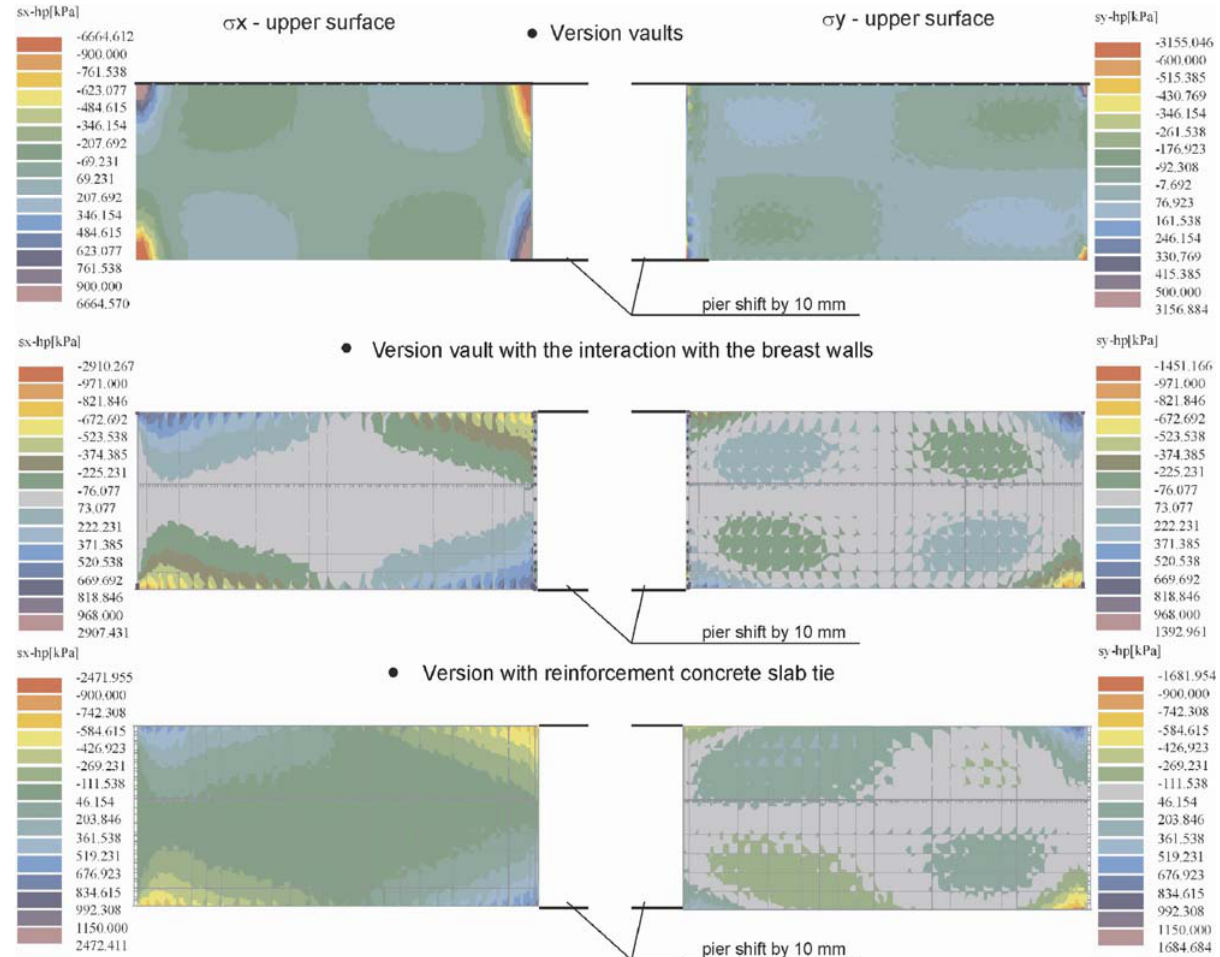
Fig 12. Field of normal stresses σ x (longitudinal) and σ y (transverse) in bridge vault at bridge pier shift by 10 mm